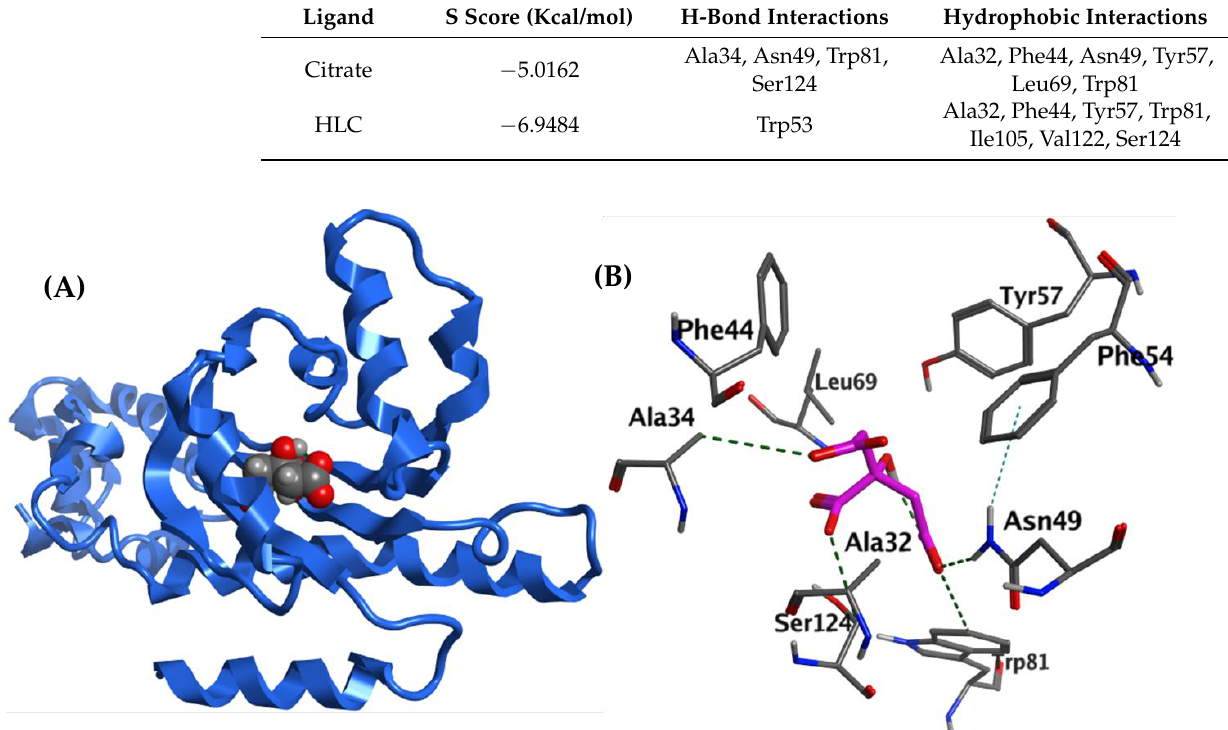
Figure 8. ( A ) 3D Citrate (Filled space shape)— S. marcescens SmaR model (blue ribbon). ( B ) 3D citrate— S. marcescens SmaR interactions, citrate is thick purple sticks, amino acid residues are grey sticks, and H-bonds are shown as dark green dots.